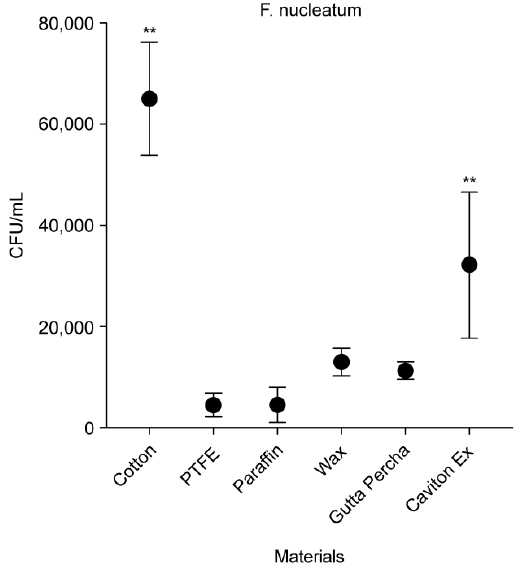
Figure 8. Colony forming units per mL of F. nucleatum adhesion against different materials. Data are expressed as mean ± standard deviation ( n = 8; ** p < 0.01).